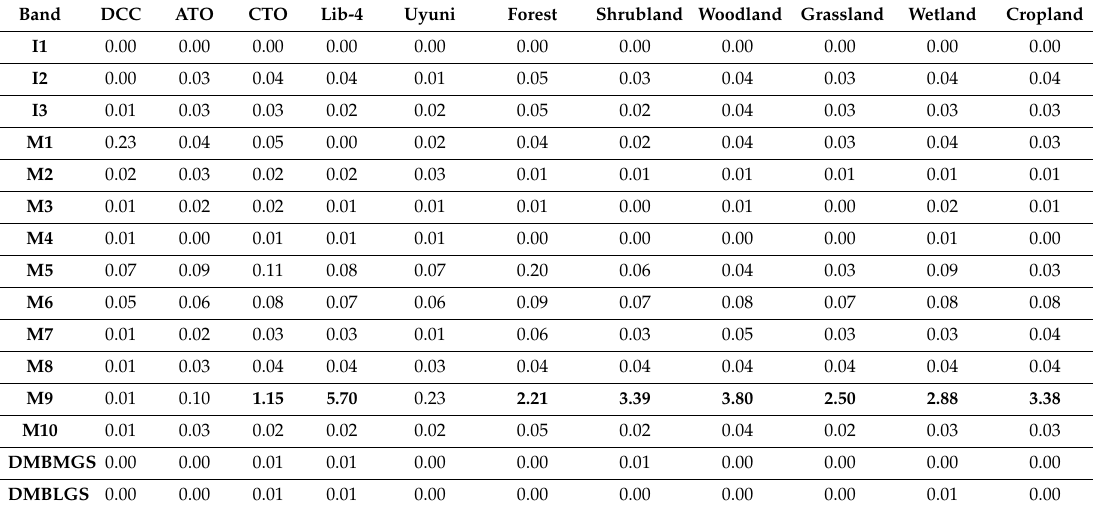
Table 10. JPSS-2 VIIRS V2 RSR Earth-reflected scene-dependent γ for measured 1% extended bandpass limits, shown in